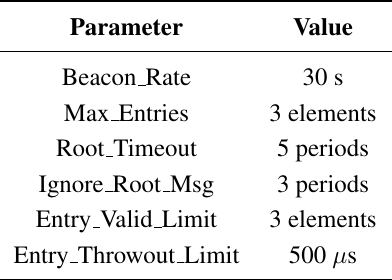
Table 2. Parameters used in FTSP, AT (Adjusted Temperature)-FTSP and A2T (Advanced Adjusted